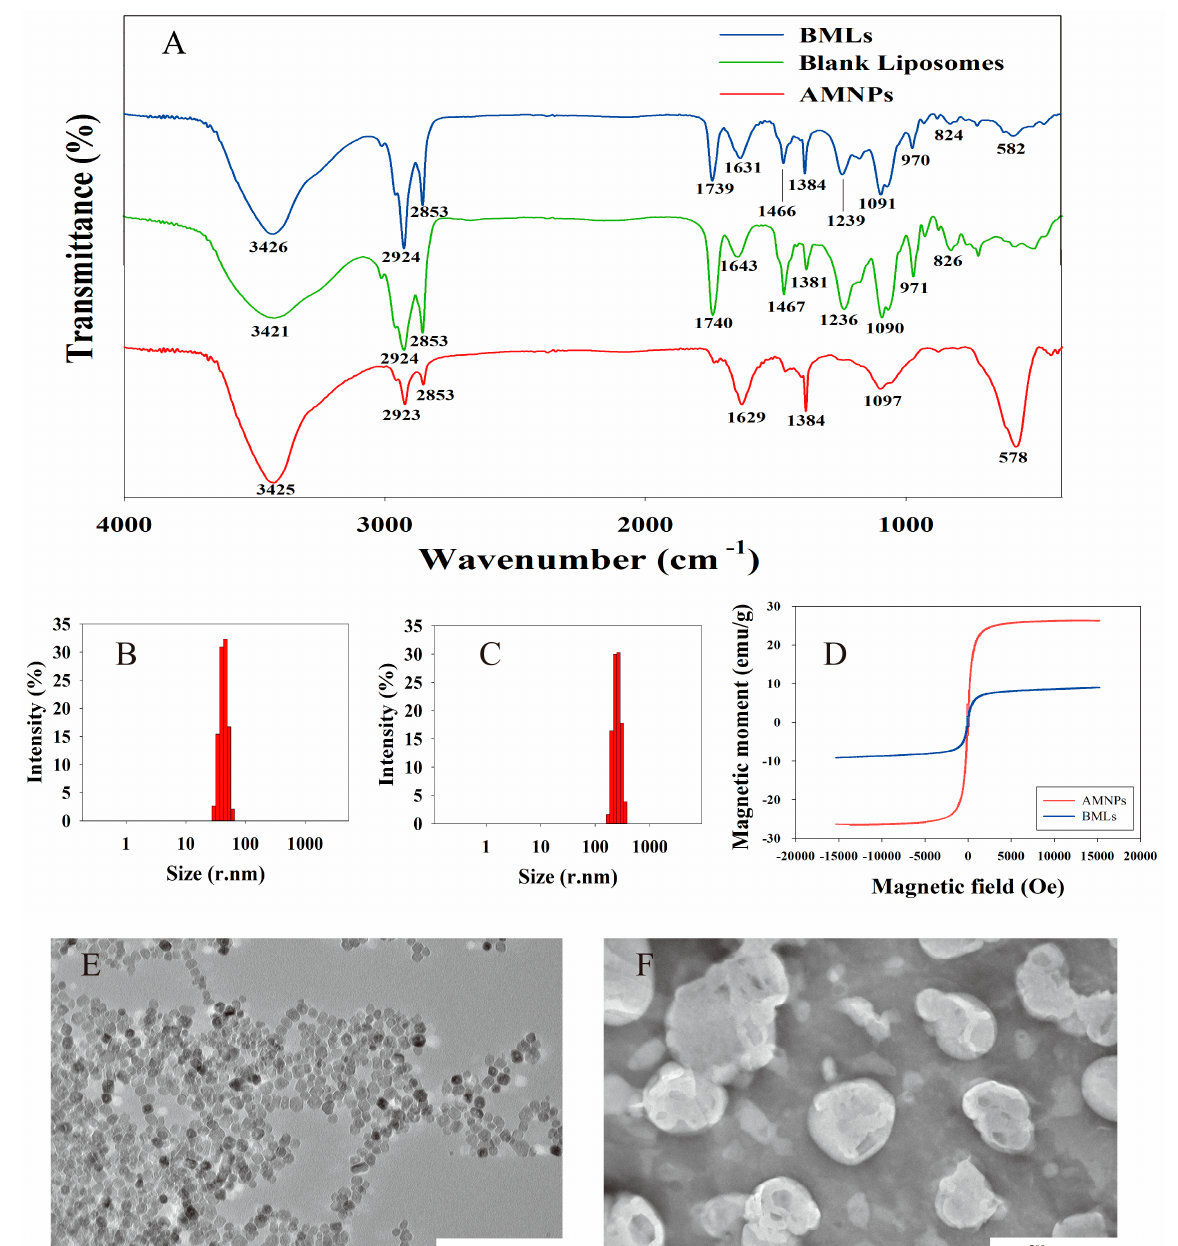
Figure 2. Characterization of bubble-generating magnetic liposomes (BMLs): FTIR spectroscopy of BMLs, blank liposomes, and amino-modified magnetic nanoparticles (AMNPs) ( A ). Particle size distribution of AMNPs ( B ) and BMLs ( C ). Magnetic hysteresis loops of BMLs and AMNPs ( D ). TEM images of AMNPs ( E ) and BMLs ( F ).